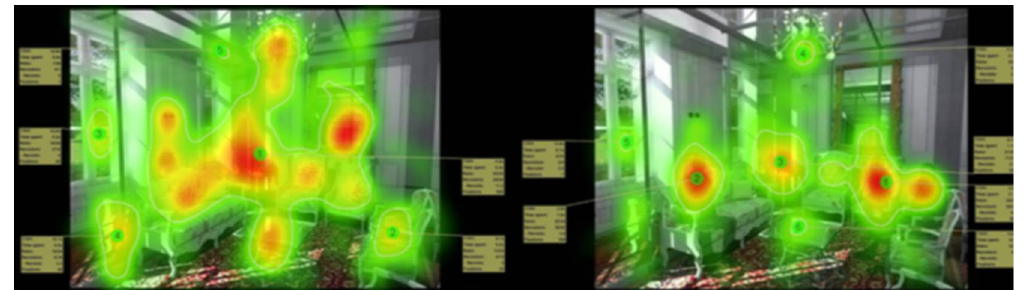
Figure 6. Recordings of the visual attention on interior renderings (designer Charline LeBrun). In the image on the left there are no people: visual attention focuses on details of the interior environment. On the right there are people (black silhouettes): fixation points focus on them. Research by Ann Sussman© geneticsofdesign.com